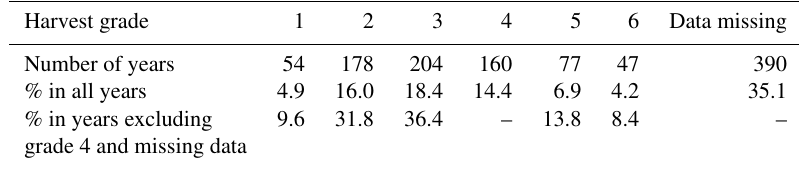
Figure 3. The chronology (vertical line in the top row of each panel) and frequency (star–line, 50-year moving window with a decadal time step) of extreme drought (red) and flood (blue) in the (a) North China Plain, (b) Jianghuai area, (c) Jiangnan area, and (d) whole of eastern China from 801 to 1910. The black line in panel (d) indicates the same frequency of co-reporting of extreme drought and flood for the whole of eastern China. The stars represent intervals with significantly more or less extreme drought and flood compared with all other intervals, based on the Wilcoxon rank sum test. The bars on the bottom row of each plate illustrate confidence levels (probability of being correct, PBC) for each reconstruction at 50-year intervals. Extremely high confidence (PBC>99%): dark; very high confidence (PBC>90%): 50% shaded dark; high confidence (PBC>80%): 25% shaded dark; medium confidence (PBC>50%): 12.5% shaded dark; and low confidence (PBC>33.3%): blank. (e) The temperature series over China (at a decadal resolution) for comparison, which was reconstructed based on 28 temperature proxies using principal component (PC) regression and partial least squares (PLS) regression (Ge et al., 2013). Table 2. Number of years and percentage for each harvest grade and missing data, 801–1910. Harvest grade